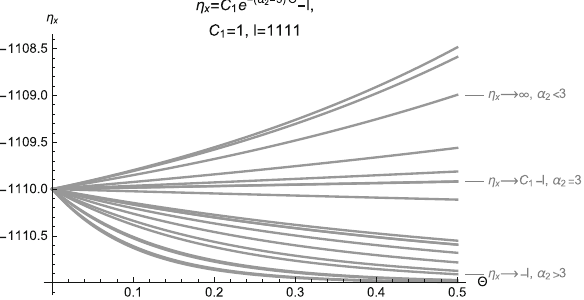
Fig. 18 Variation of η x with respect to (cid:16) for S